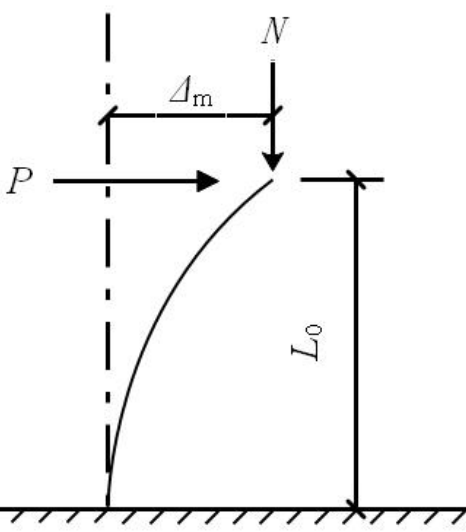
Figure 7. Schematic views of CFST stub columns under cyclic load.